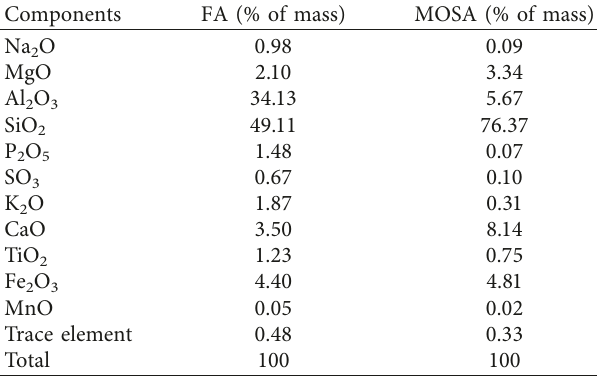
Table 1: Chemical composition of FA and MOSA (%wt.).